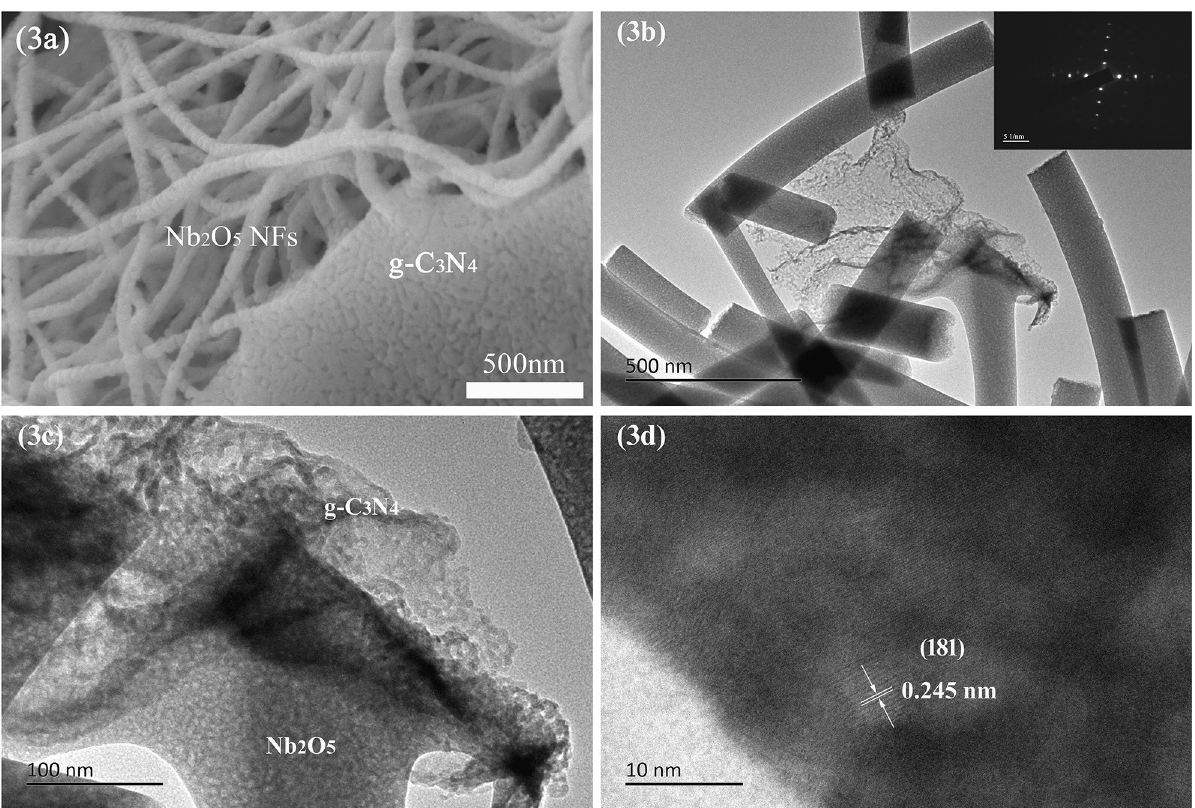
Figure 3. ( a ) SEM, ( b , c ) TEM and ( d ) high resolution TEM images of g-C 3 N 4 /Nb 2 O 5 heterojunction. The inset of ( b ) is SAED pattern of g-C 3 N 4 /Nb 2 O 5